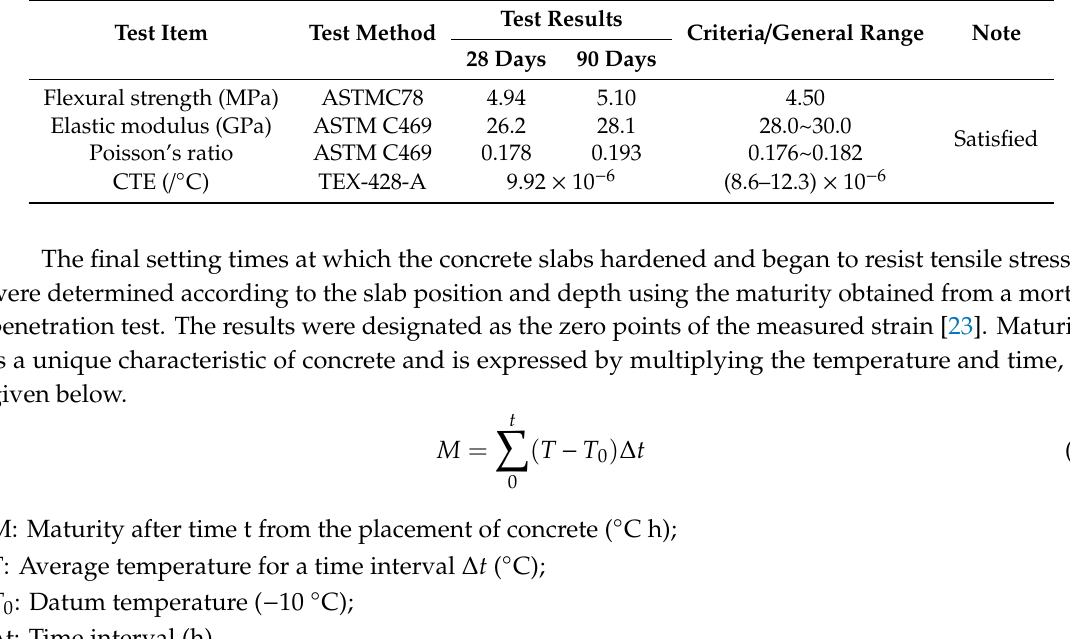
Table 2. Material properties of a concrete slab.